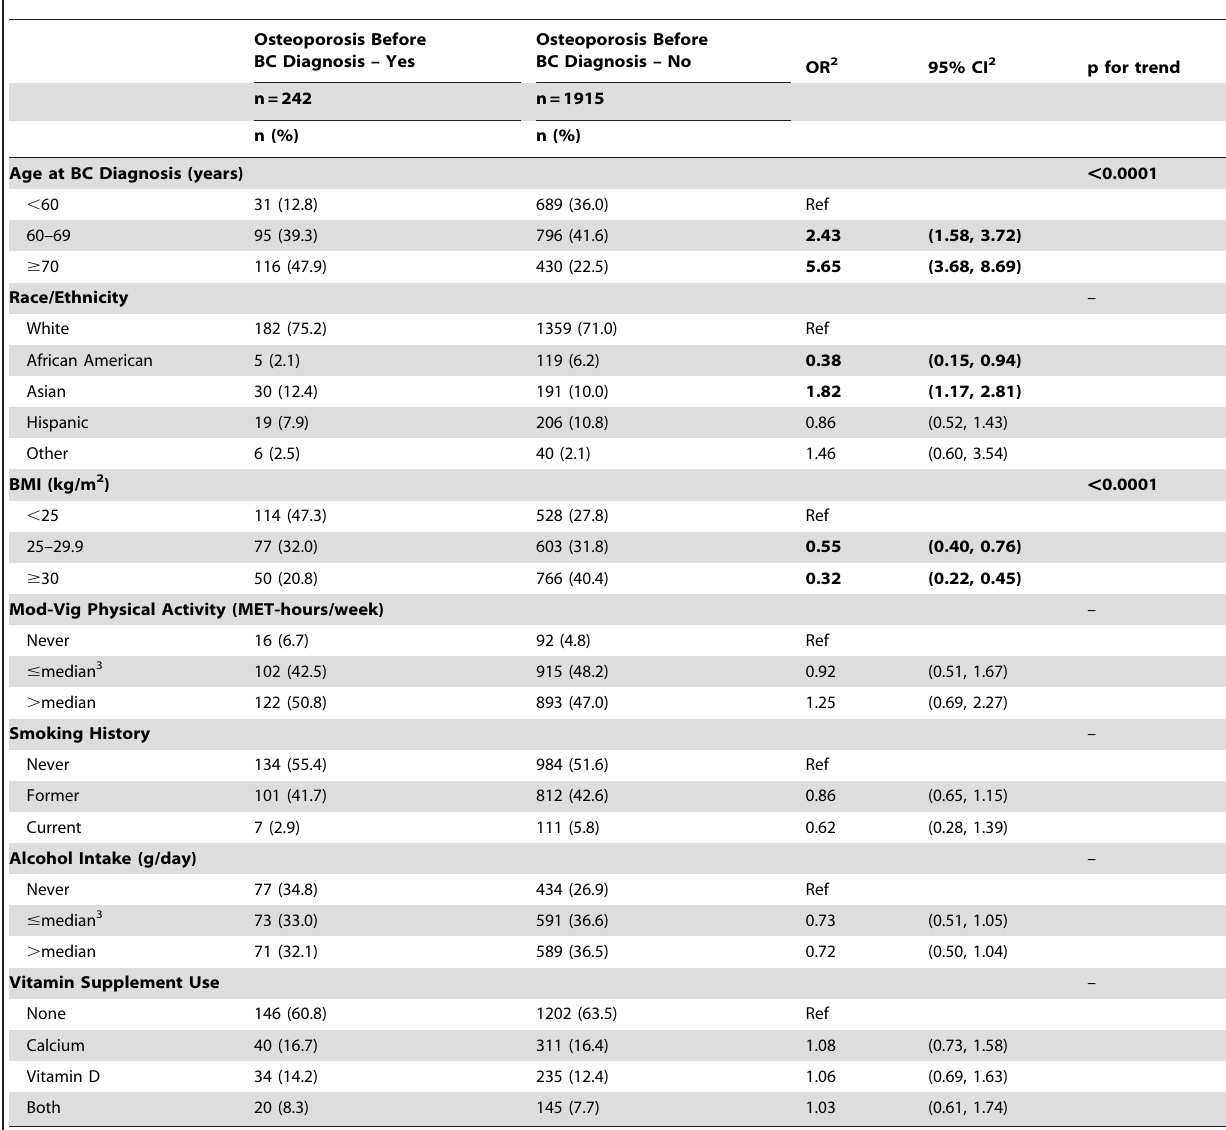
Table 2. Baseline characteristics in relation to osteoporosis 1 before breast cancer diagnosis (BC) in aromatase inhibitor (AI) users.